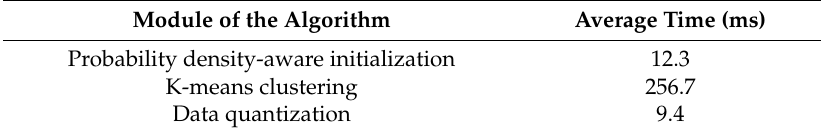
Table 6. Extra computational cost for each part of the algorithm in the tightly-coupled training